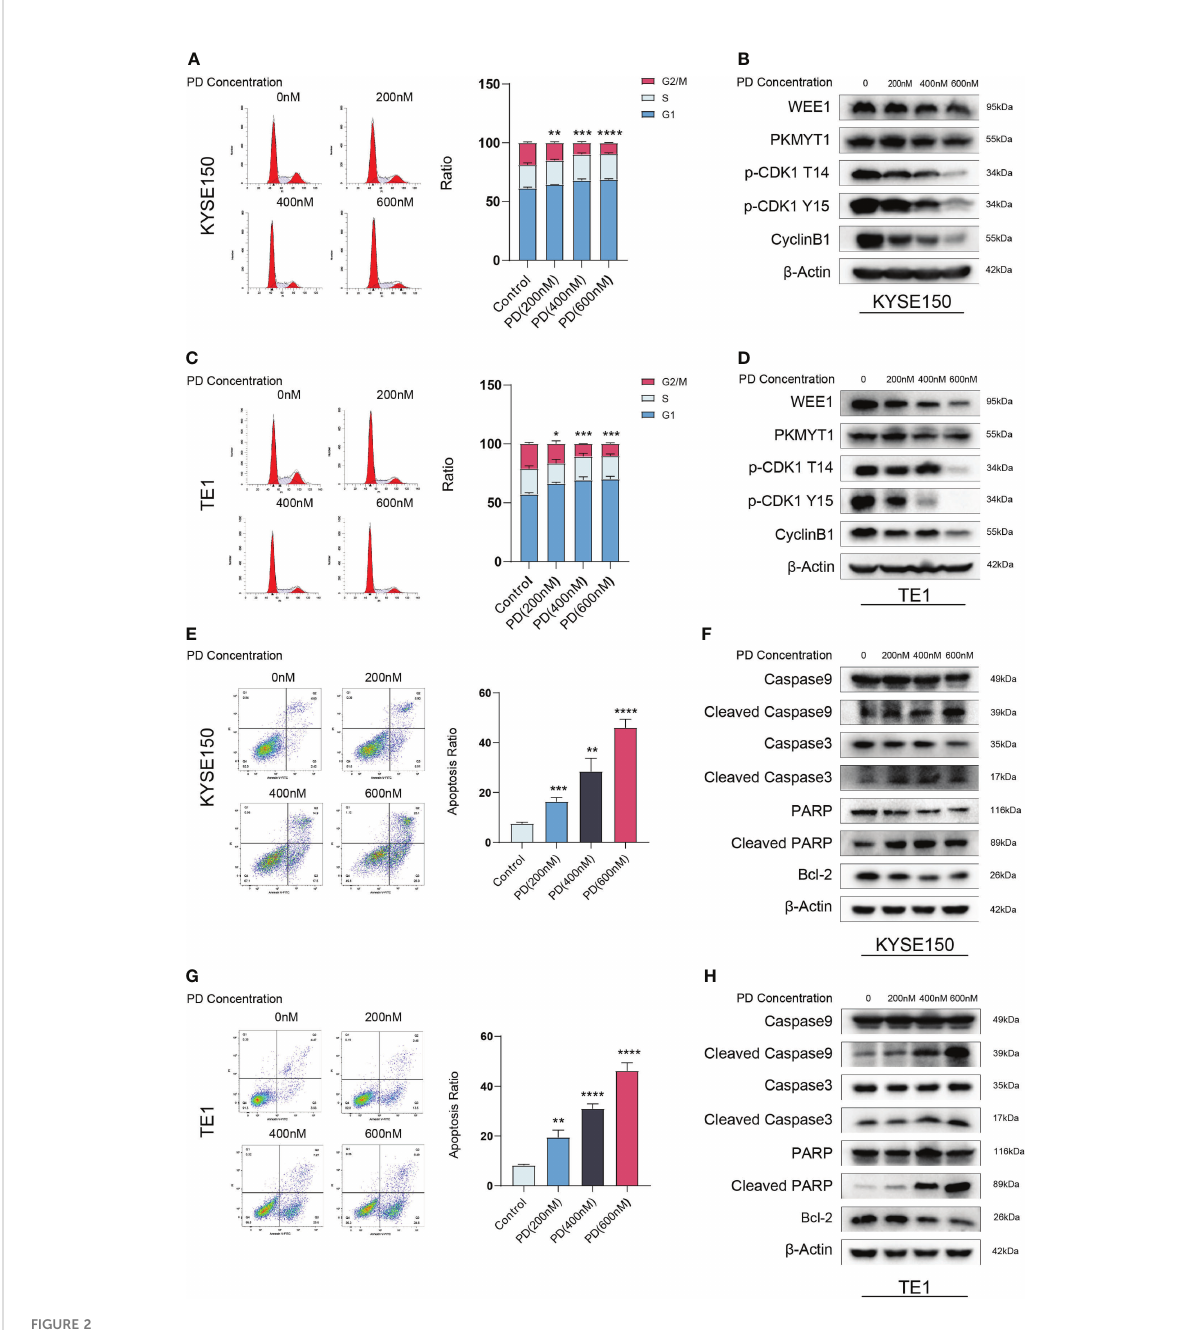
FIGURE 2 PD exerts antitumor effects in a dose-dependent manner. (A, C) PD decreased the G2/M ratio in KYSE150 and TE1 cells. (B, D) PD inhibits the protein levels of WEE1, PKMYT1, p-CDK1-T14, p-CDK1-Y15 and CyclinB1 in a dose-dependent manner. (E, G) PD induces cell apoptosis in ESCC cells with escalating PD concentrations. (F, H) PD induces changes in the expression of apoptosis-related proteins. *P < 0.05, **P < 0.01, ***P < 0.001, ****P < 0.0001.